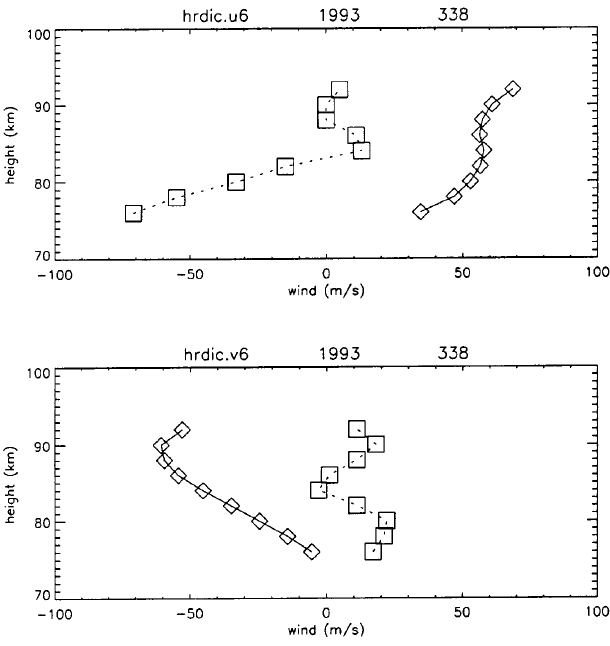
Fig. 12. Wind profiles for the individual overpass occurring on 3 December 1993: Zonal wind (upper panel), meridional wind (lower panel). HRDI diamonds,